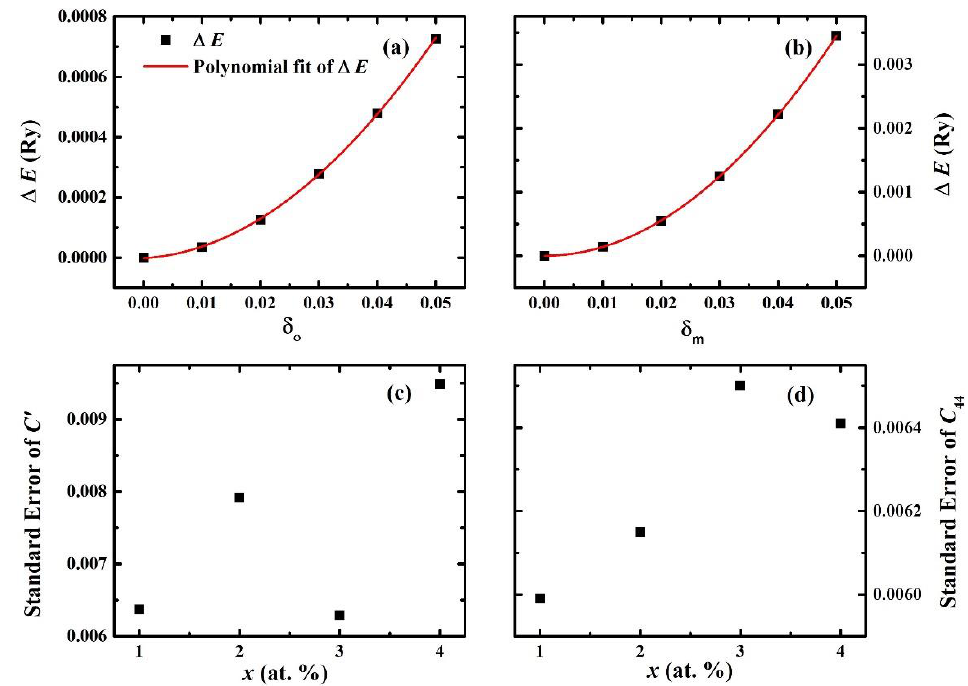
Figure 1. ( a ) Total energy change (Equation (1)) as a function of orthorhombic deformation δ o of the fcc structure of a paramagnetic Fe 0.59 Cr 0.2 Ni 0.2 Al 0.01 alloy. ( b ) Total energy change (Equation (2)) as a function of the monoclinic deformation δ m of the fcc structure of a paramagnetic Fe 0.59 Cr 0.2 Ni 0.2 Al 0.01 alloy. The red curves in ( a ) and ( b ) represent the polynomial fit of the total energy change. ( c ) The standard error in C ’ and ( d ) the standard error in C 44 of Fe 0.6− x Cr 0.2 Ni 0.2 Al x ( x = 0.01, 0.02, 0.03, 0.04) alloys as a function of x .